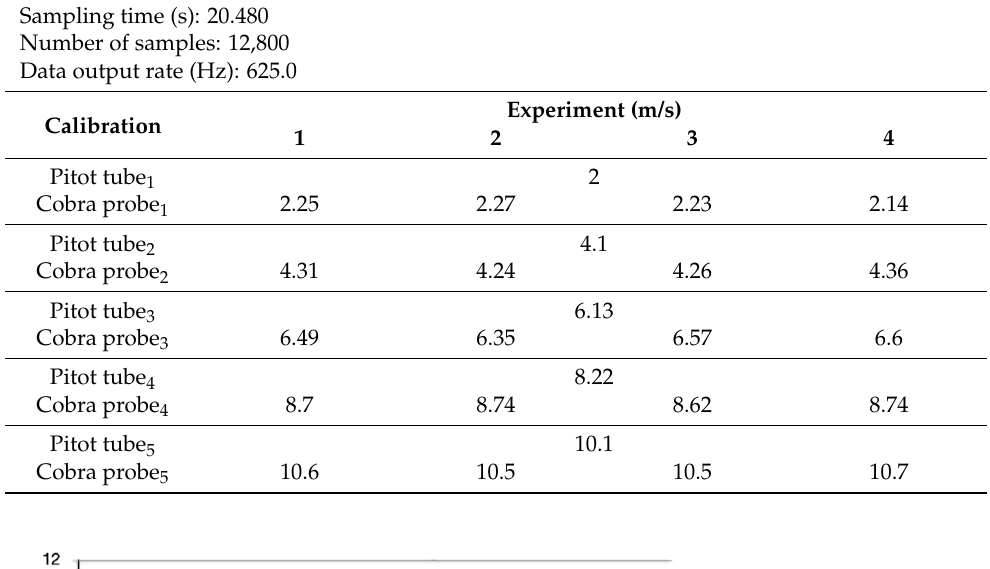
Table 1. Simple experiment to equate the wind tunnel result between the pitot tube and the cobra probe.